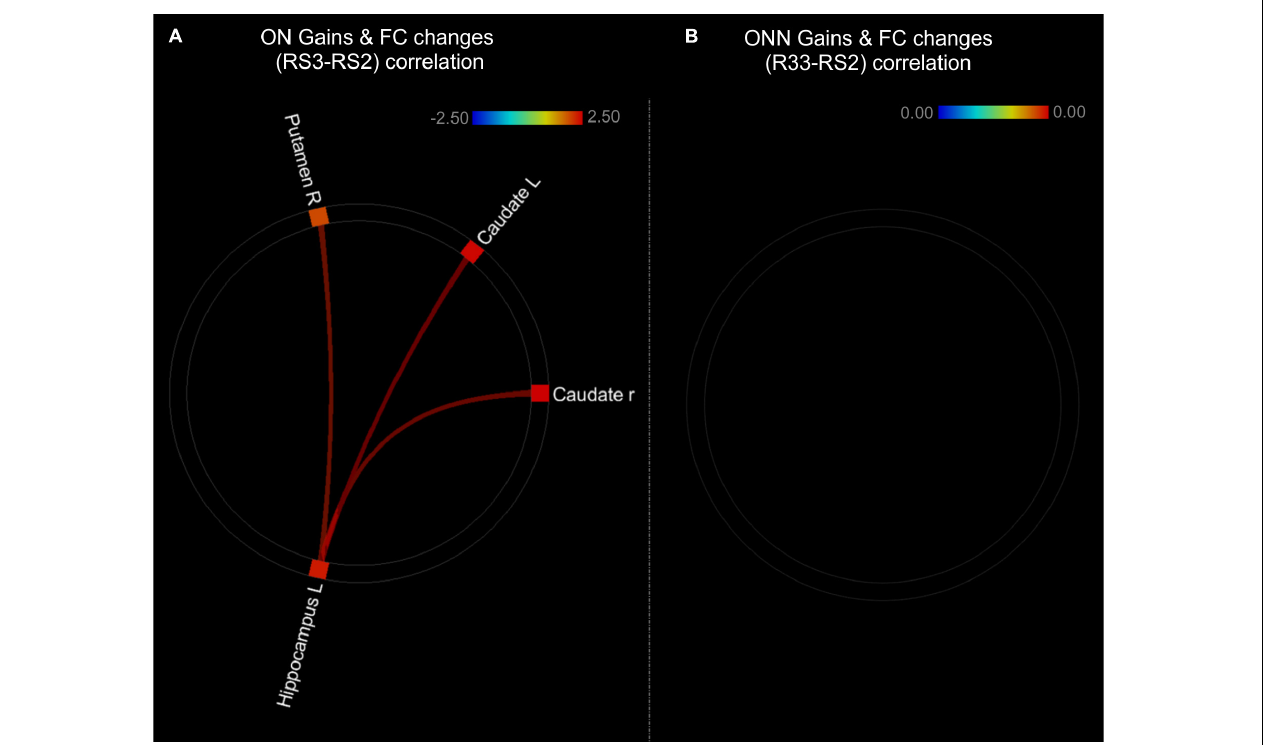
FIGURE 9 | Associations between post-MSL FC changes and performance gains in (A) ON group; (B) ONN group. Thresholded at p FDR < 0.05. ON, Older Nap; ONN, Older No